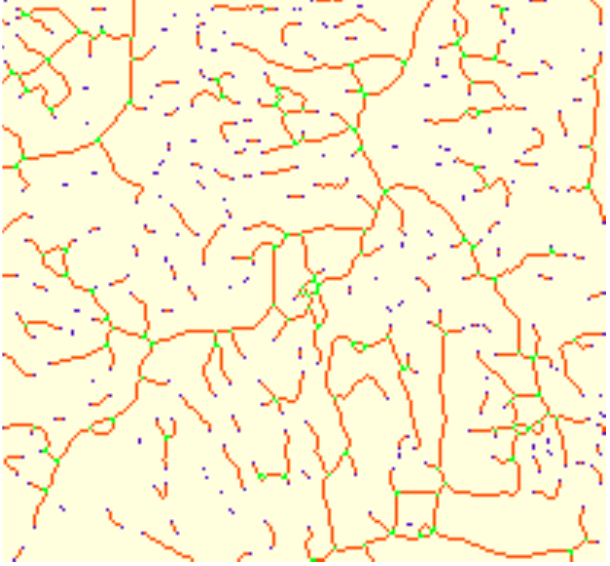
Figure 2. Branch length distribution, Method A, for normal (N, left) and tortuous (T, right) reti- nal OCTA.